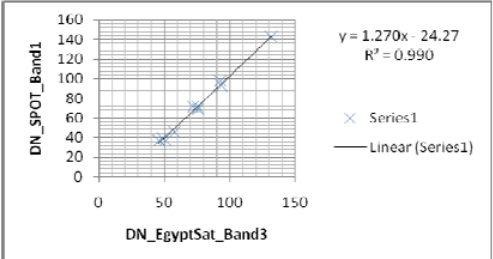
Table 2: Digital numbers for Egyptsat-1 and SPOT-4 at identical selected features